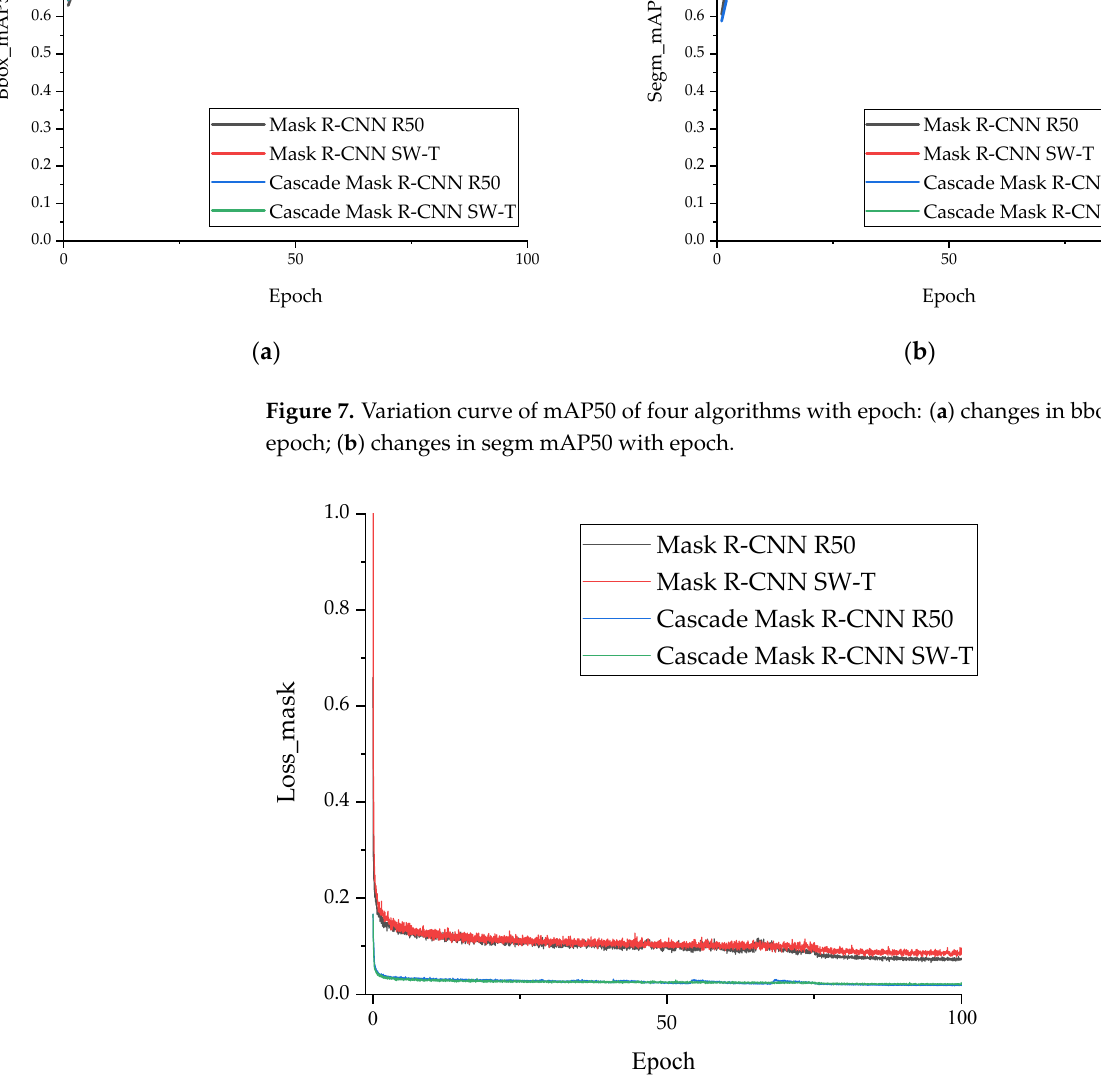
Figure 8. Loss mask graph of four algorithms. When the IoU is 0.5, the AP values of the trunks, primary branches and supports under the four algorithms are shown in Figure 9. As can be seen from the figure, for the trunks and primary branches, the four algorithms have higher AP values and show better detection and segmentation effects. Among them, the AP difference between the trunks and the primary branches is small. In the identification of supports, Cascade Mask R-CNN performs better than Mask R-CNN. Compared with Mask R-CNN R50, the bbox AP and segm AP of Cascade Mask R-CNN R50, respectively, increase by 8.1% and 6.3%. Compared with Mask R-CNN SW-T, those of Cascade Mask R-CNN SW-T increase by 18.8% and 16.1%. The AP values of Swin-T are noticeably higher than Resnet50. Compared with Mask R-CNN R50, the bbox AP and segm AP of Mask R-CNN SW-T increase by 40.2%